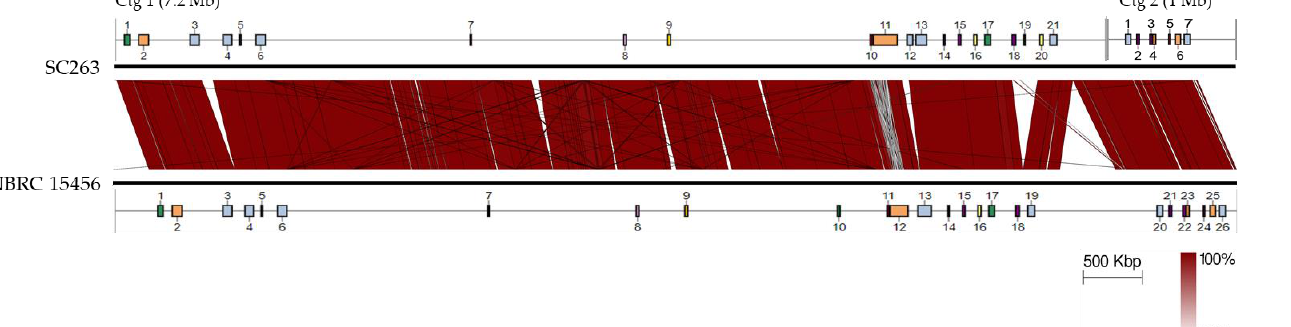
Figure 7. Genome comparison between SC263 and Streptomyces spororaveus NBRC 15456. Biosynthetic gene clusters (BGCs) were predicted using antiSMASH 6.0 webserver and numbered by the order of these two strains in the top and bottom lines, respectively. Genome comparison between these two strains was generated using EASYFIG v. 2.2.5 and placed in the center, where dark red displayed in 100% nucleotide identity and the color was gradually toward white with the percentage of identity.